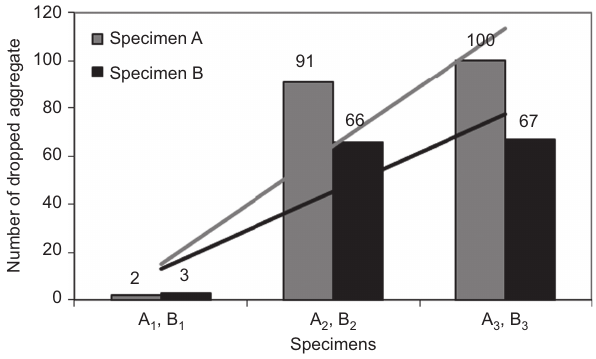
Figure 4 Vialit adhesion test